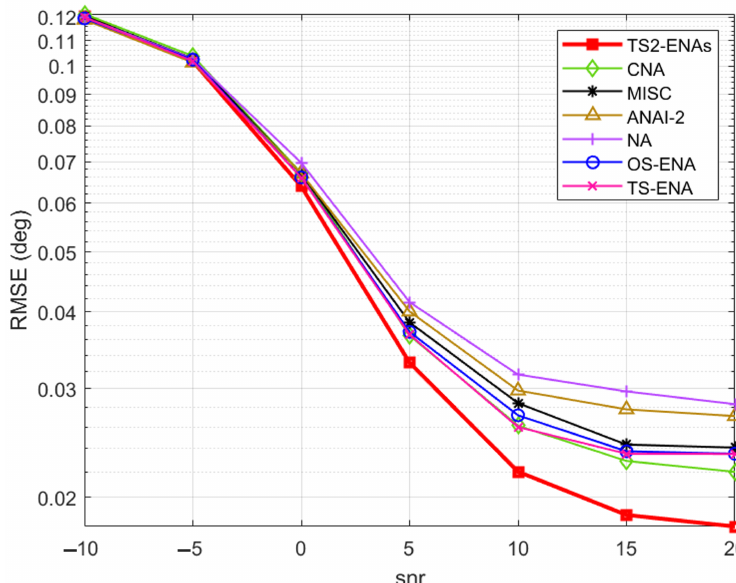
Figure 9. RMSE vs. snr.